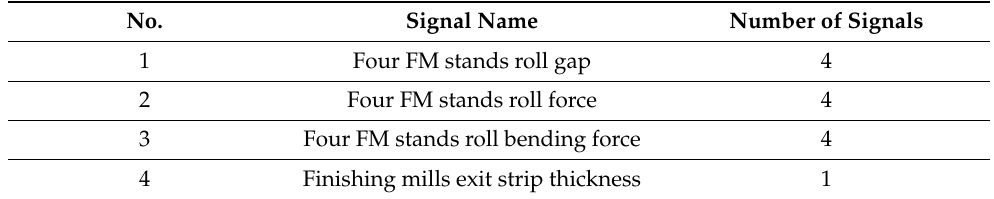
Table 3. AGC-related signals. No.